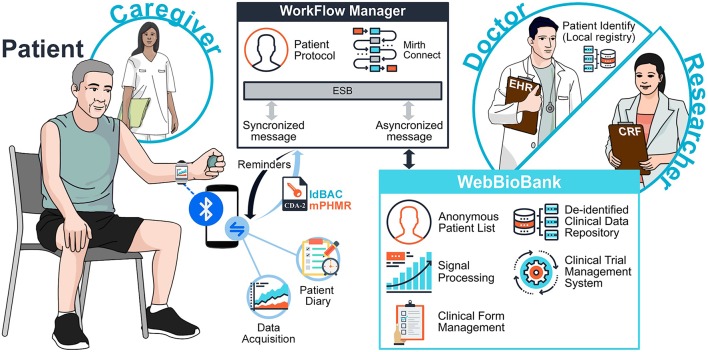
System Architecture.